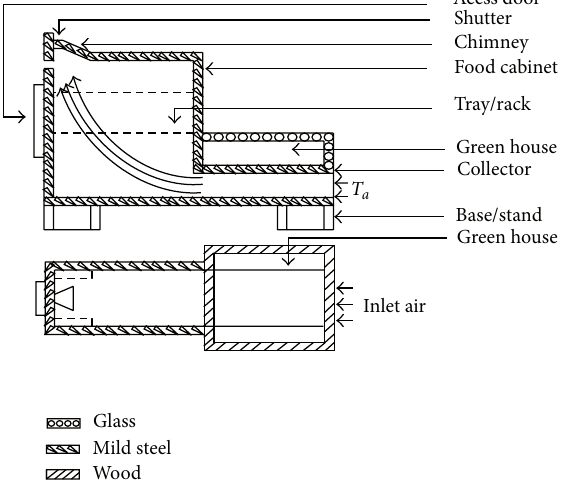
Figure 1: Diagram of solar dryer.